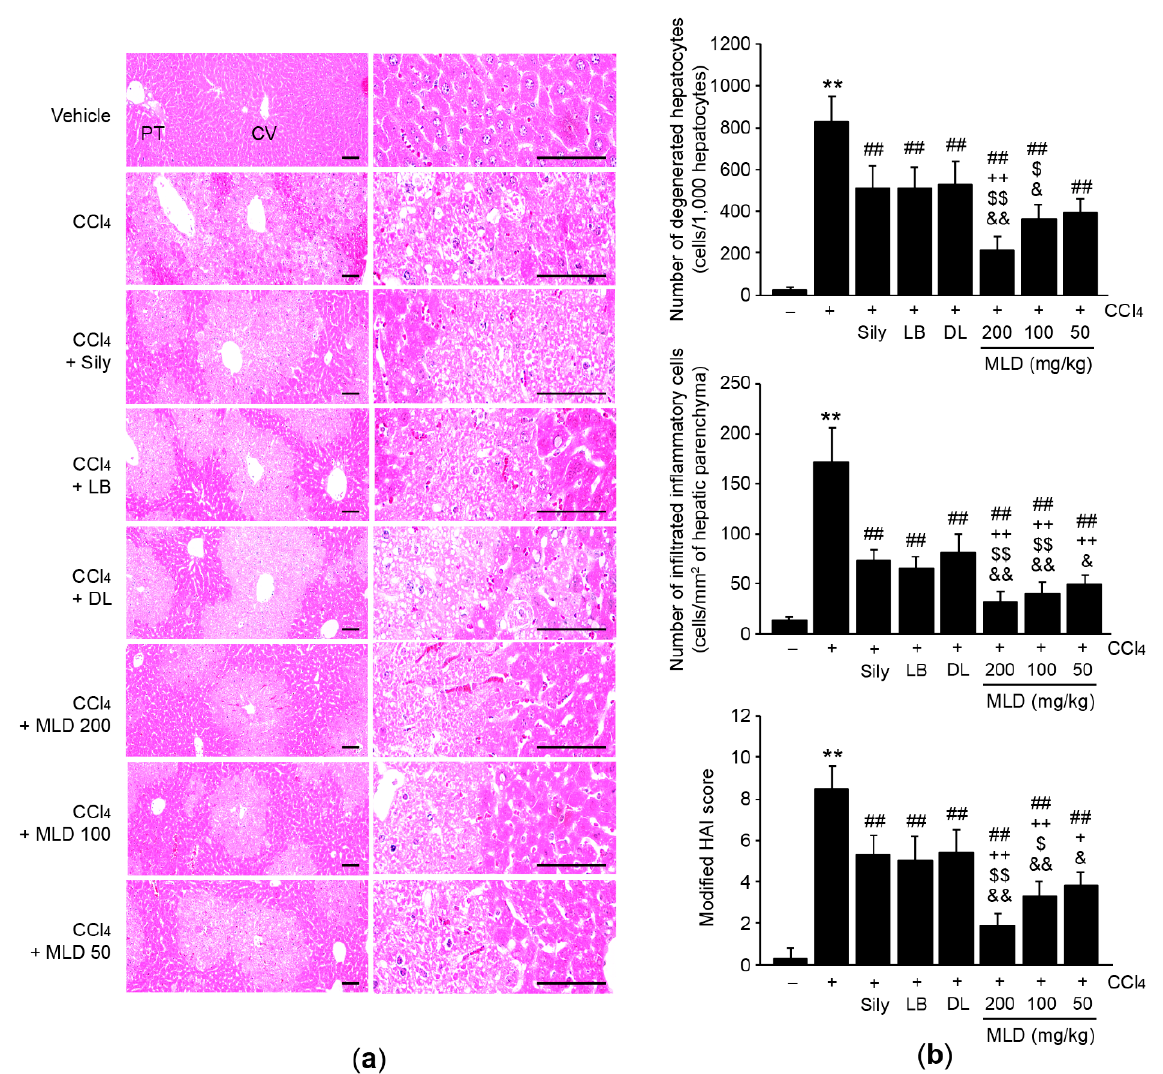
Figure 2. MLD protects the liver from CCl 4 -induced damage. ( a ) Representative hepatic tissues stained with hematoxylin and eosin. Scale bars, 200 µ m. ( b ) The numbers of degenerated hepatocytes (upper) and infiltrated inflammatory cells (middle), and modified HAI scores (lower) were quantified using an image analyzer. All values are expressed as mean ± SD of ten mice. ** p < 0.01 between the vehicle and CCl 4 groups; ## p < 0.01 versus CCl 4 -injected mice; ++ p < 0.01, + p < 0.05 between Sily- and MLD-treated mice; $$ p < 0.01, $ p < 0.05 between LB- and MLD-treated mice; && p < 0.01, & p < 0.05 between DL- and MLD-treated mice. CV, central vein; PT, portal triad.